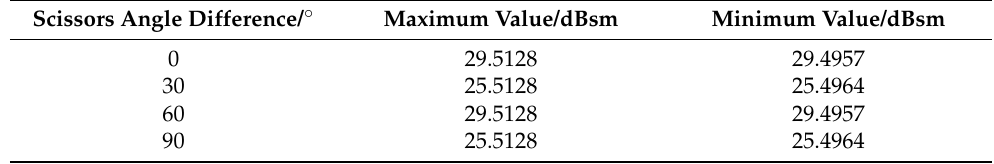
Table 15. Highest and lowest average RCS values at an azimuth angle = 90 ◦ in fixed-wing mode. Scissors Angle Difference/